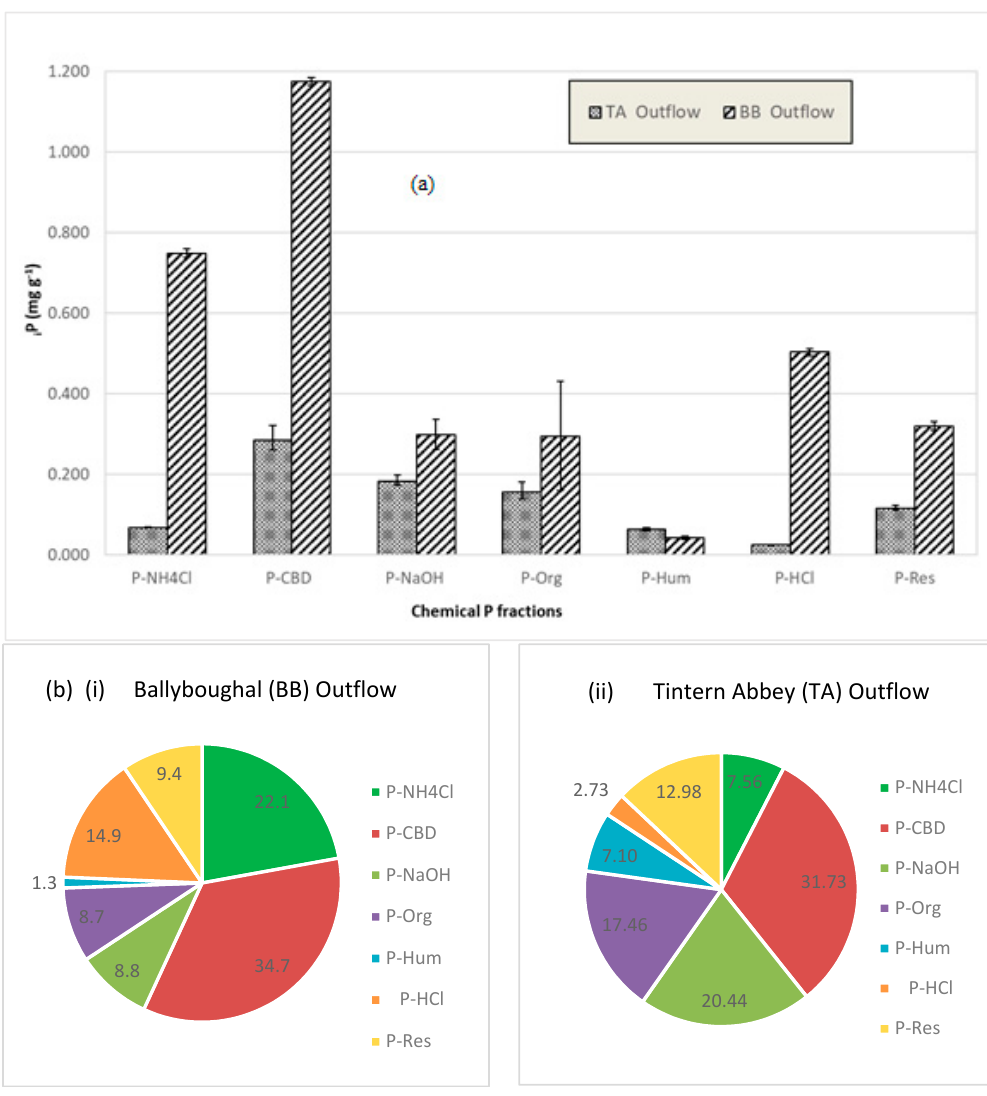
Figure 3. ( a ) Sequential chemical P fraction pools including total P (mg g − 1 DW) for ( a ) Ballyboughal outflow (BB) and ( b ) Tintern Abbey outflow (TA); ( b ) sequential chemical P fractionations in relative percent (%) for ( i ) Ballyboughal (BB) outflow and ( ii ) Tintern Abbey (TA) outflow.